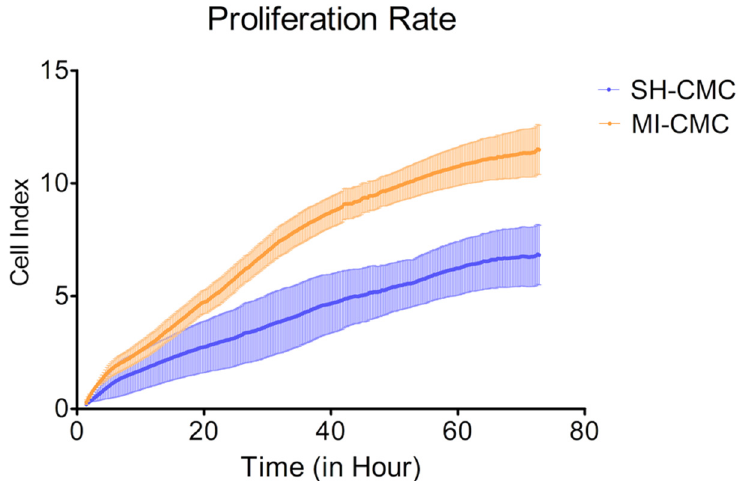
Figure 4. The proliferation rate of postinfarction cardiac mesenchymal cells (MI-CMC, orange curve, n = 9) and healthy cardiac mesenchymal cells (SH-CMC, blue curve, n = 3). Each curve represents the average values between the samples and the standard error of the mean (vertical lines). Horizontal—the time during which the measurements of proliferative activity were taken every 15 min. The experiment lasted for 72 h. Vertical—the value of the cell index, which reflects the quantitative information about the biological status of cells, including their number and viability. The seeding density was 5000 cells per well. The significance of differences between the SH-CMC and the MI-CMC is p < 0.05 with D’Agostino and Pearson omnibus normality